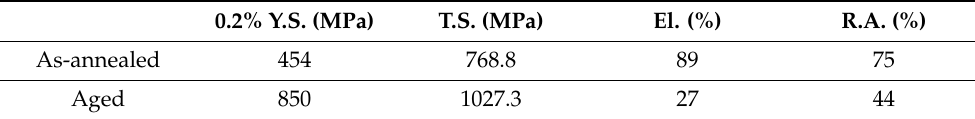
Figure 5. Comparison of the stress-strain curves before and after the aging heat treatment. Table 2. Tensile properties of the as-annealed and the aged lightweight steels.